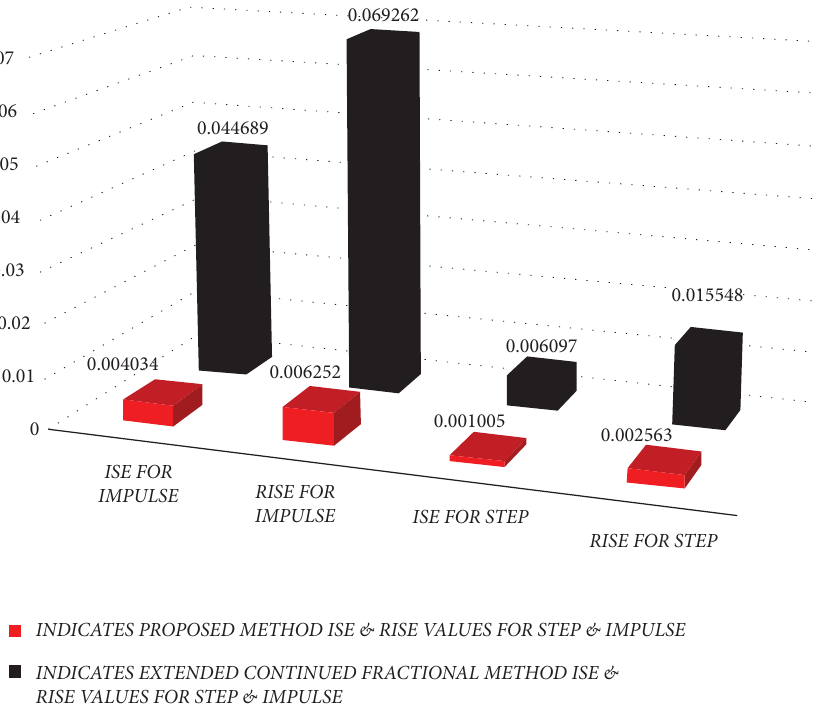
Figure 4: Graphical representation of performance indices obtained by the proposed method and extended continued fractional method